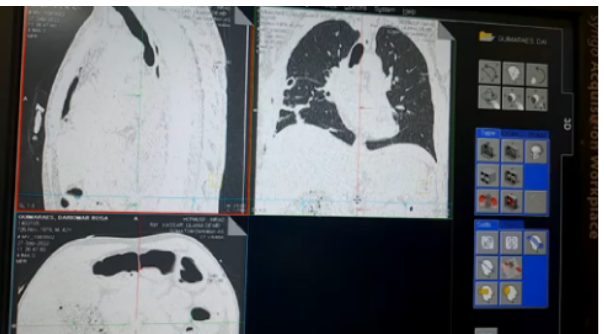
Figure 18. Manipulation and visualization of images from the tomograph via 5G network.